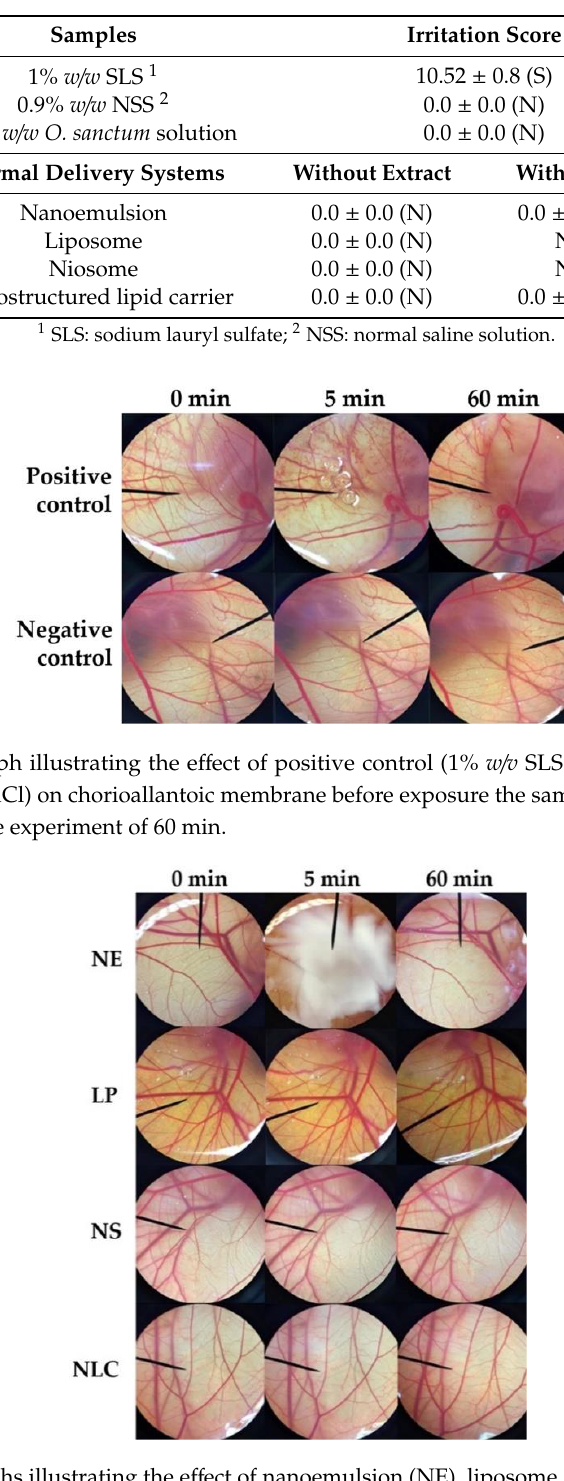
Table 4. Classification of dermal delivery systems with and without O. sanctum ethanolic extract according to the score of severity.